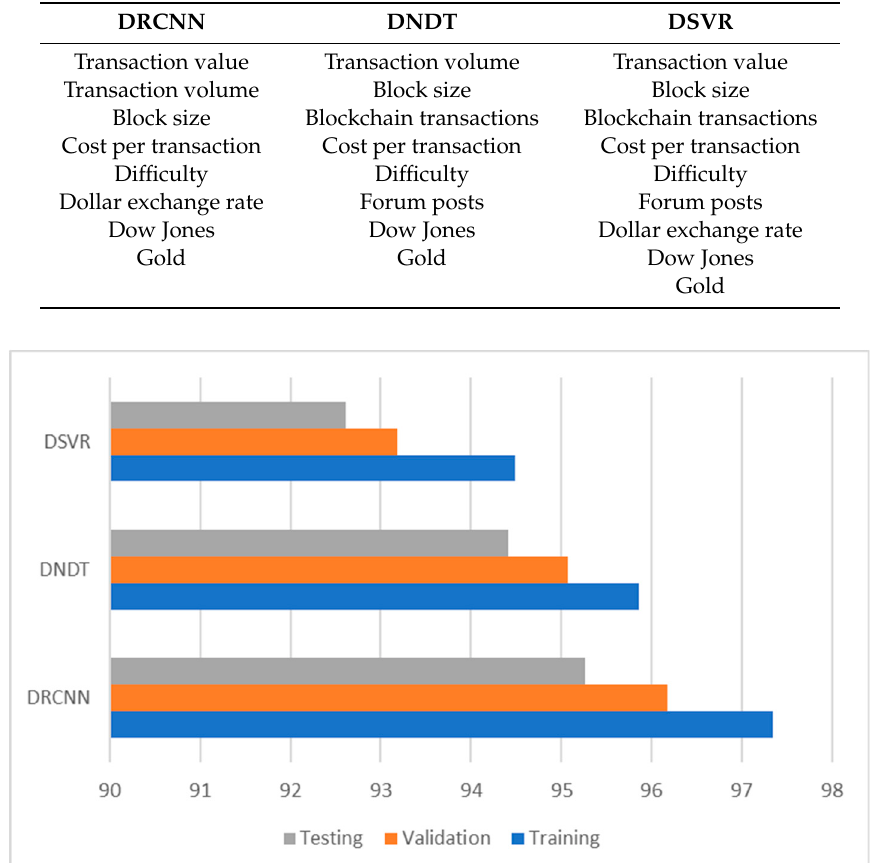
Table 3. Results of accuracy evaluation: classification (%). Table 4. Results of accuracy evaluation: greater sensitivity variables.